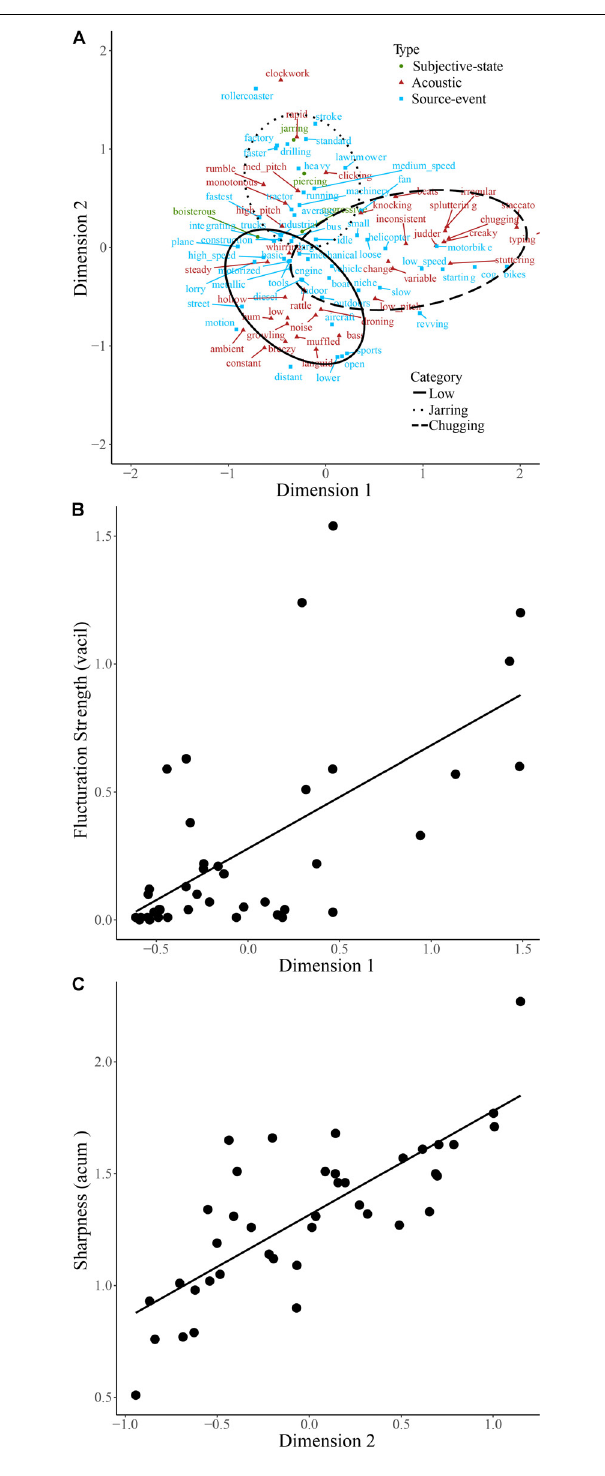
FIGURE 5 | Descriptive words used to describe engine sounds plotted on the first two dimensions of categorization data (A) . Words are colored according to type. The regions of the two-dimensional space corresponding to the three main categories of engine sounds are indicated by solid, dashed, and dotted lines. Fluctuation strength (B) and sharpness (C) of engine sounds are plotted against their coordinates on dimensions 1 and 2,